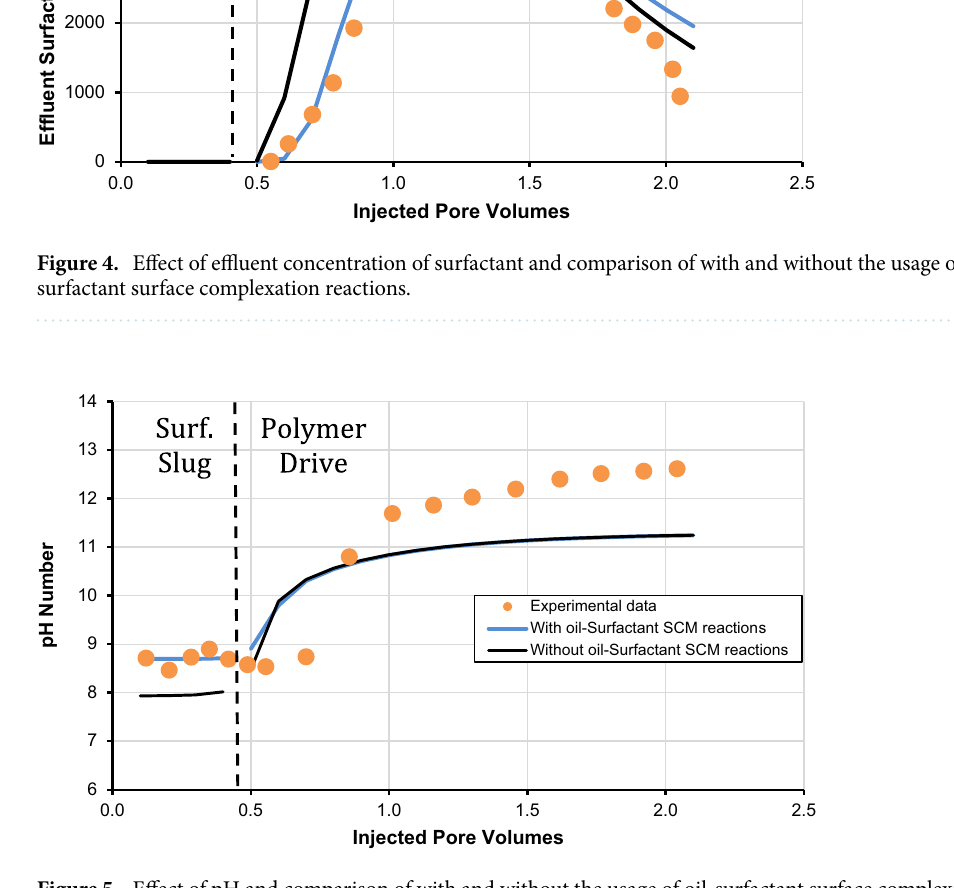
Figure 5. Effect of pH and comparison of with and without the usage of oil-surfactant surface complexation